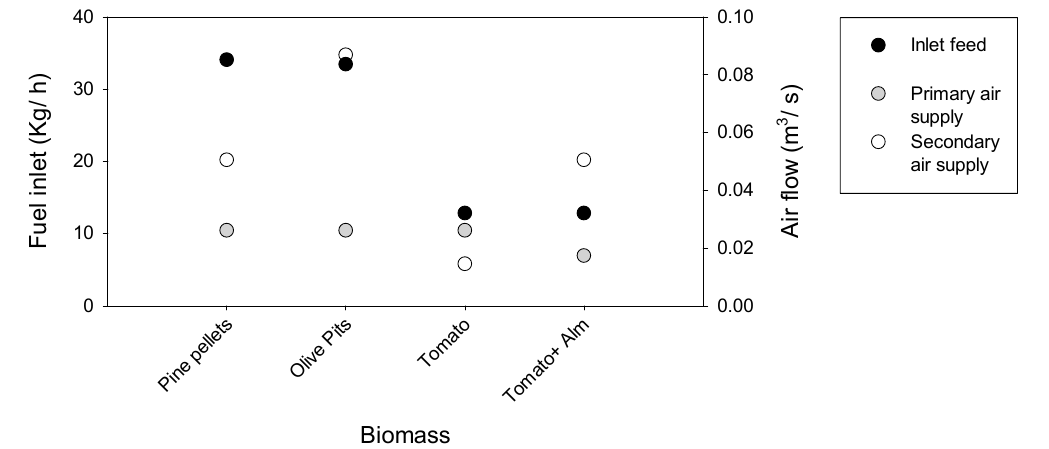
Figure A9. Configurations for which the best combustion performance was found for each biomass type studied.